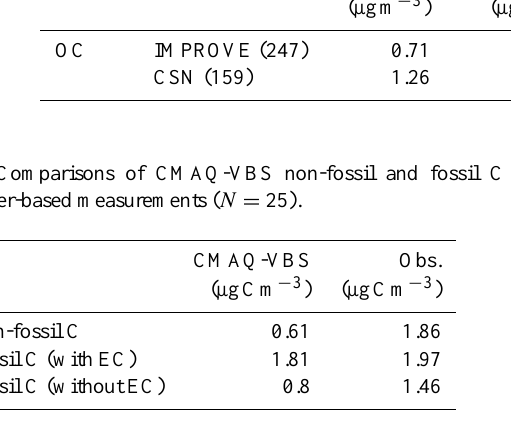
Figure 7. CMAQ-VBS modeled primary OA concentrations from gasoline vehicles (a) , diesel vehicles (b) , meat cooking (c) , biomass burning (d) , and “other” sources (e) . Note the scale for diesel vehicles is an order of magnitude lower than for other sources. Table 4. As in Table 3 but for CMAQ-VBS organic carbon (OC) model predictions in sensitivity simulations with aging of biogenic SOA. Species Network Mean obs. Mean model